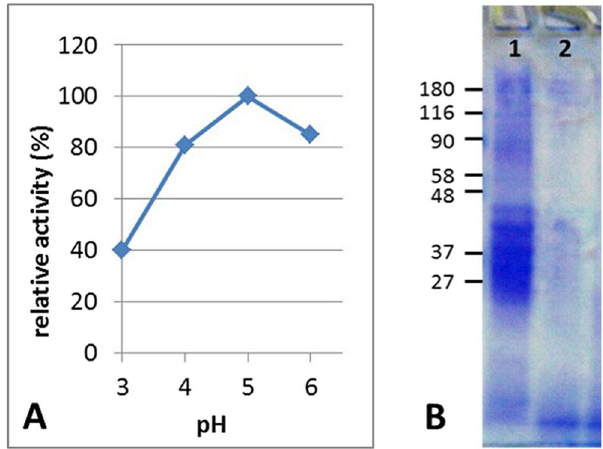
Figure 1. Activity of Actinoallomurus A8 culture supernatant fraction “ < 100 kDa” containing the wild Endopep-40. ( A ) Activity toward the substrate sucAlaAlaProPhe-AMC at various pH values. X axis: pH value, Y axis: relative activity (%). ( B ) Gliadin digestion by the wild E40 containing supernatant fraction after 2 hour of incubation at 37 °C, pH 3. Gel stained with Coomassie R250 brilliant blue. Lane 1: gliadin alone, lane 2: gliadin + E40 ( < 100 kDa